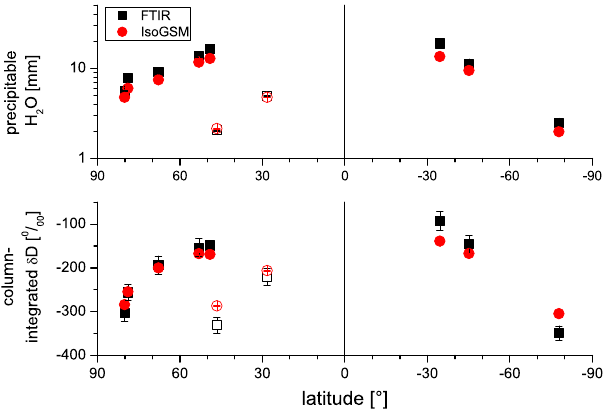
Fig. 13. Multi-year mean of column-integrated data versus latitude. Upper panel: total precipitable water vapour; Bottom panel: column-integrated δ D. Black squares: FTIR data; Red dots: IsoGSM simulations. The values from high-altitude stations are distinguished by open symbols.